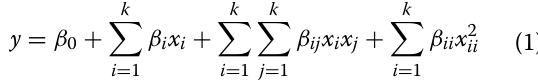
points were employed in this study (Table 2). The data were fitted with the second-order polynomial model by